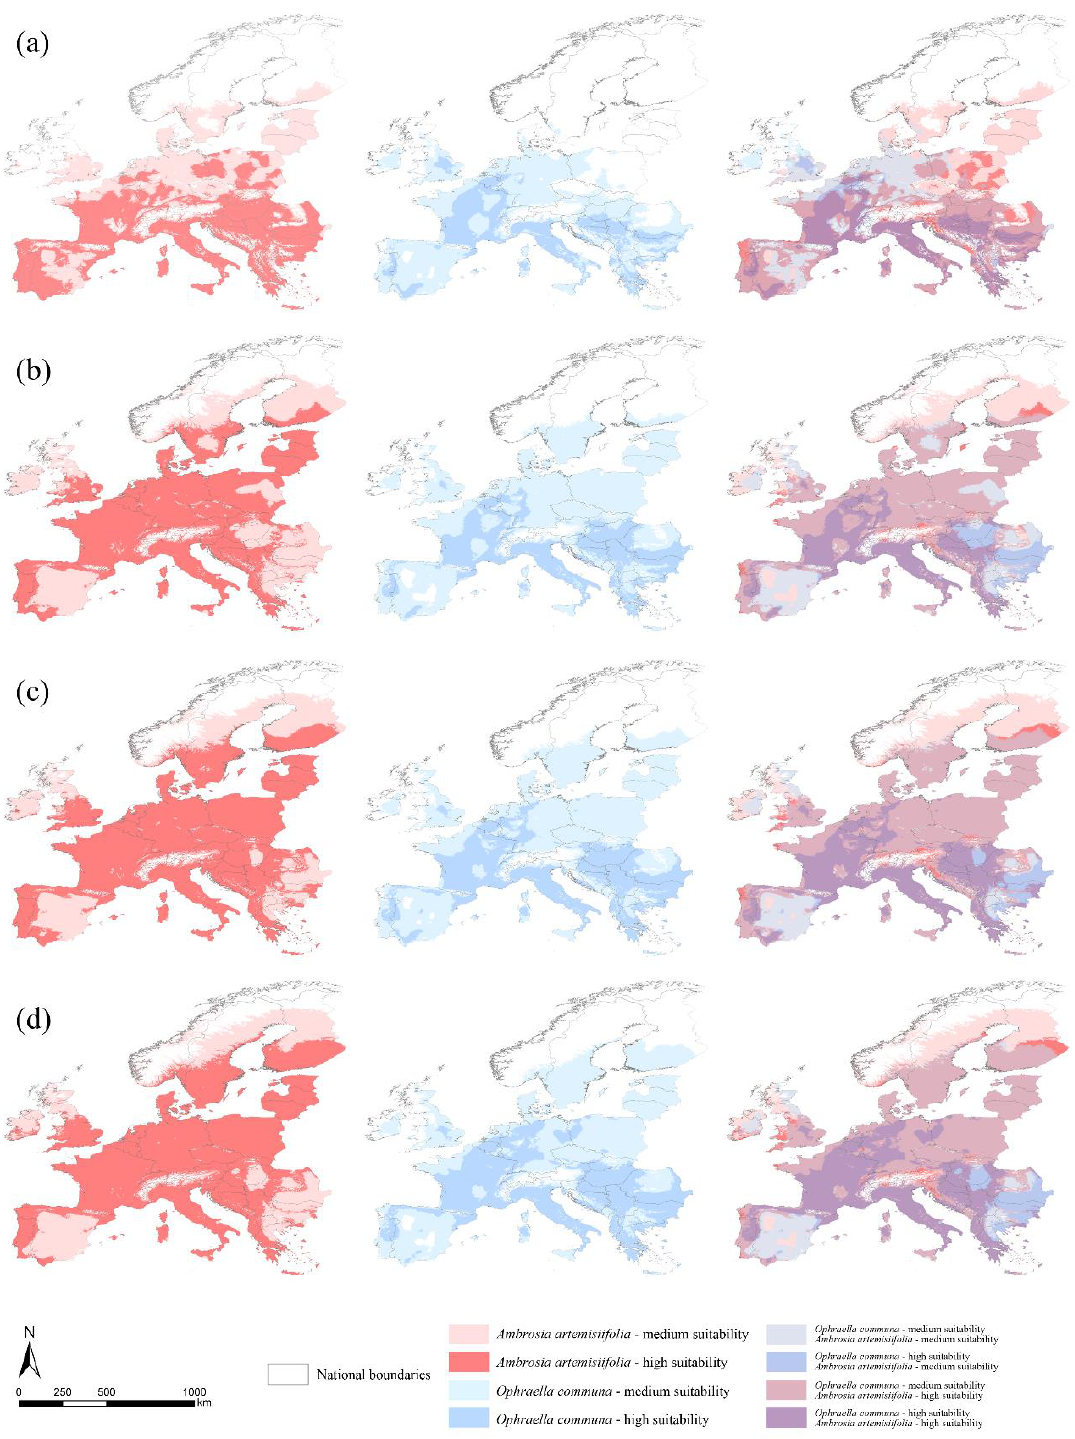
Figure 3. Maps of predicted suitability for Ambrosia artemisiifolia and Ophraella communa for current and future climate scenarios. Models of predicted suitability (low suitability areas are not displayed for graphical purposes; these correspond to white zones for both target species) obtained for Ambrosia artemisiifolia (red) and Ophraella communa (blue), and the overlap between them, for current ( a ), 2050 —